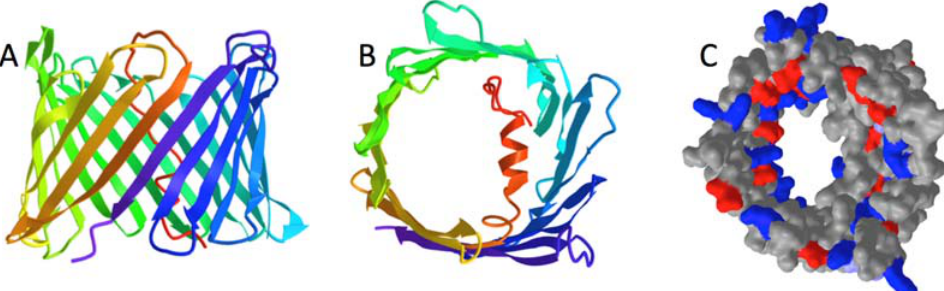
Figure 1. Atomic models for human VDAC1 (hVDAC1) from ( A , B ) NMR and ( C ) X-ray crystallography. Side ( A ) and top-down ( B ) views of the polypeptide chain of PDB 2K4T [15]. For these and subsequent ribbon models, mitochondrial intermembrane space (IMS) is down and cytosol up in side views; top views correspond to 90 ° rotation towards the viewer. The spectrum color scheme used is RED at N-terminus and VIOLET at C-terminus. ( C ) Space-filling (van der Waals) model for top-down view of the polypeptide chain of PDB 2JK4 [16] with cationic residues BLUE and anionic residues RED, illustrating how the inserted N-terminal domain narrows the pore to a projected size of approximately 12 × 15 Å. A molecule of ATP (MW 563), roughly a rod 15 Å long and 5–8 Å across, can diffuses at a rate of ~700 molecules/msec through this “open” VDAC pore, but cannot diffuse through the voltage ‐ gated “closed” pore (structure unknown) [7,8]. Atomic models generated by NMR or X ‐ ray crystallography are generally consistent with the electrophysiological properties of the bilayer “open” state and with the pro ‐ jected density maps of OM ‐ bound VDAC pores obtained by cryo ‐ EM [18]. Thus, they are